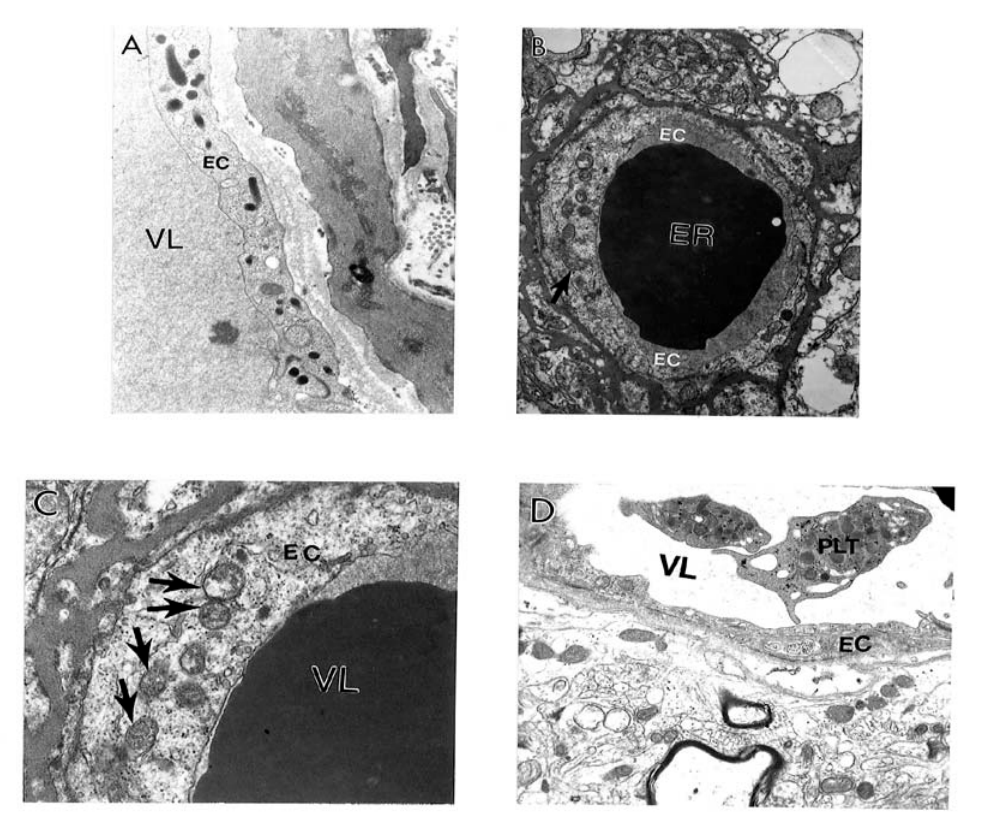
Figure 1. Ultrastructural features of the brain biopsy from the age-matched control (A) and AD (B–D) patients are characterized by heterogeneous morphology: A. An intact microvessel shows the absence of any particular abnormalities in the ultrastructure of endothelial cells (EC) and perivascular cells. Mitochondria in EC are intact.